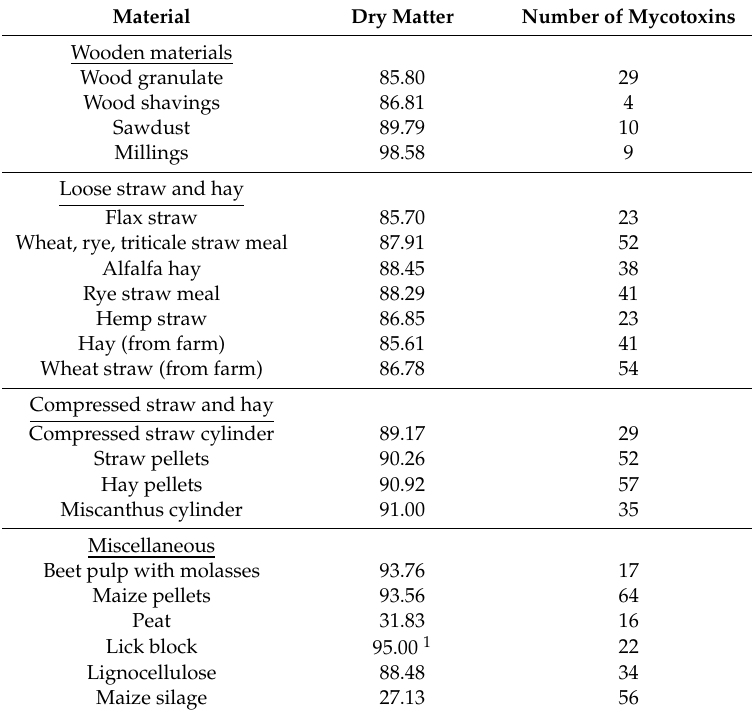
Table 3. Dry matter content (%) and total number of detected mycotoxins in the tested materials.